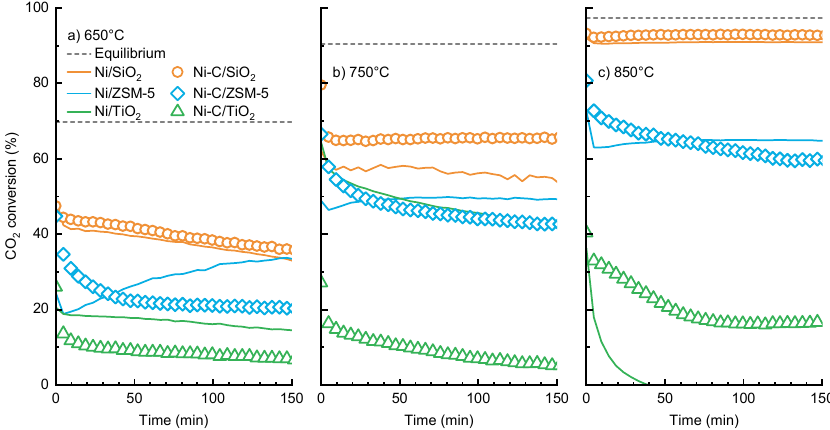
ff erent temperatures. ( a ) 650 ◦ C,